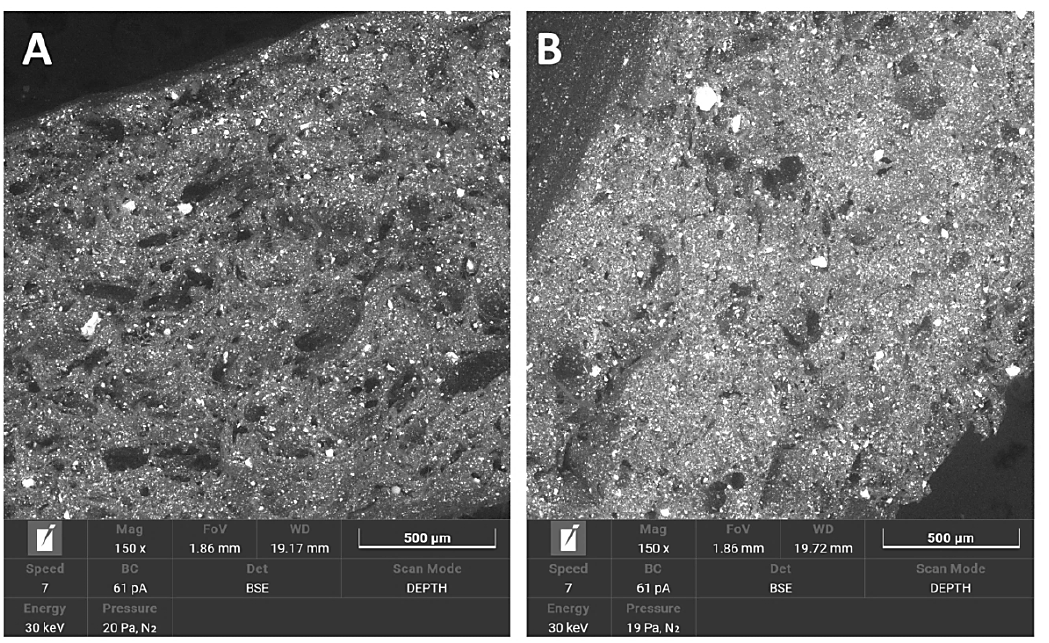
Figure 13. SEM micrographs used to compare breakthroughs of ( A ) PA12_ZrO 2 _NS and ( B ) PA12_ZrO 2 _S samples.